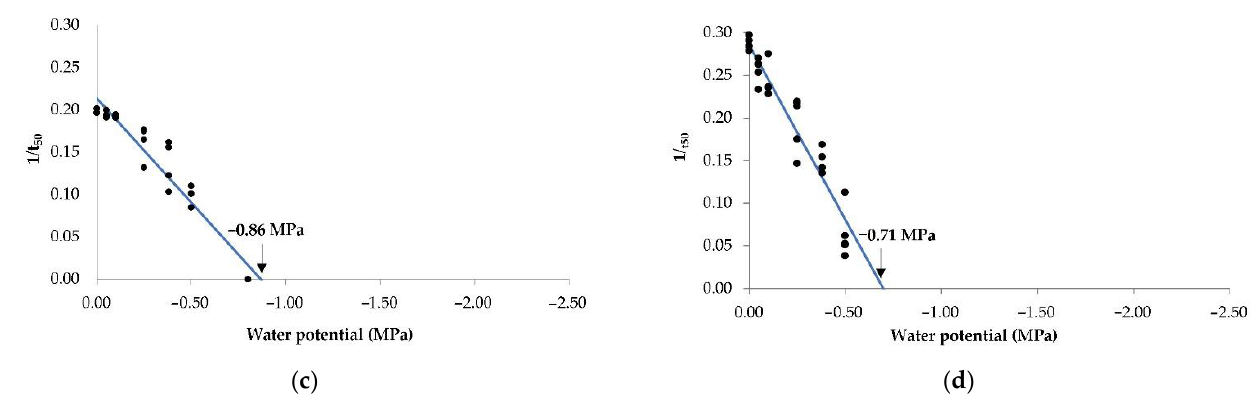
Figure 4. Estimated base water potentials (Ψ b ). The solid line represents the linear regression line, and the points represent the inverse value of the time necessary to reach 50% of germination (1/t 50 ). The estimated value of the base water potential is the intersection of the regression line with the x -axis: ( a ) Amaranthus retroflexus (Ψ b = −0.36 ± 0.03 MPa; y = 0.672x + 1.862; r 2 = 0.91); ( b ) Chenopodium album (Ψ b = −1.38 ± 0.14 MPa; y = 0.221x + 0.315; r 2 = 0.87); ( c ) Panicum capillare (Ψ b = −0.86 ± 0.07 MPa; y = 0.2466x + 0.2138; r 2 = 0.94); and ( d ) Setaria pumila (Ψ b = −0.71 ± 0.07 MPa; y = 0.409x + 0.286; r 2 = 0.92).